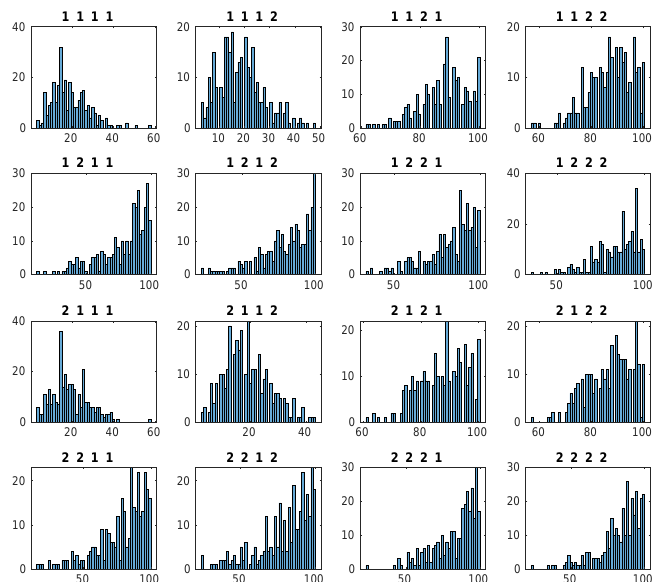
Figure A3. Histograms for all the population groups corresponding to the performance measure of the convergence of the filter. The horizontal axes represent the minimum number of steps t ∗ that lead to convergence, and the vertical ones, the number of tests.